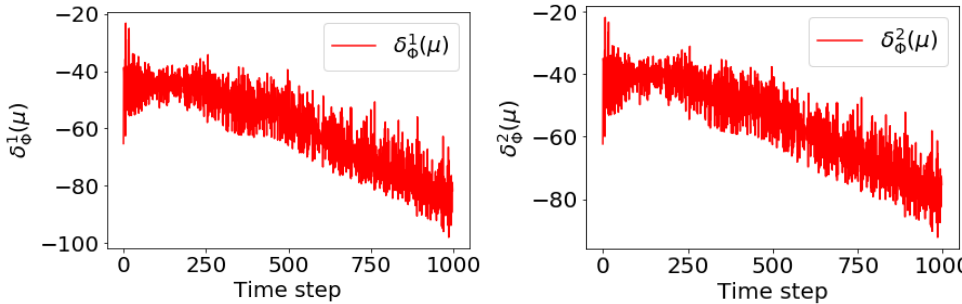
Figure 16. (Data-targeted VAE) Parametric plots of the two components of m ( µ h ( t i ) , Φ ) (red) and α ( t i ) (blue), i = 1, . . . , M .